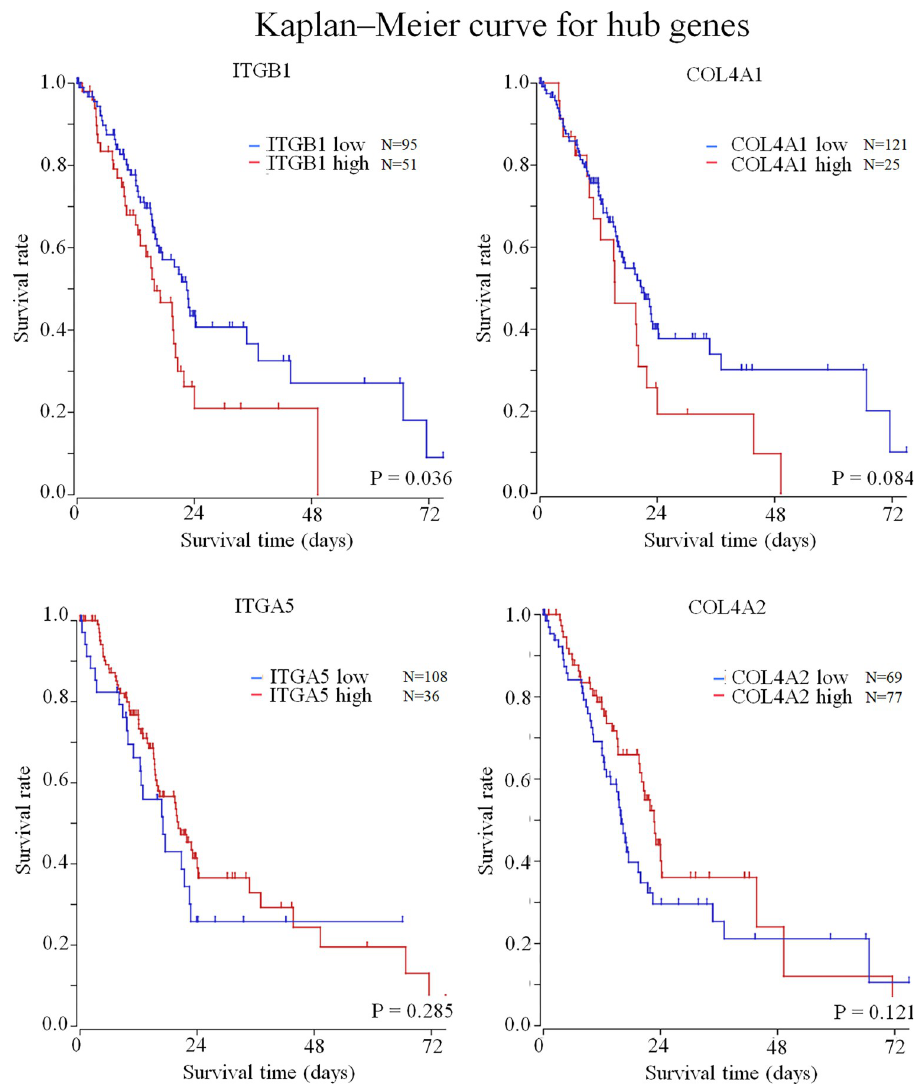
Fig 2. Kaplan–Meier curve for pre-validation of the hub genes by the R2 platform. The four hub genes detected by protein-protein interaction analysis were pre-verified for prognosis using the R2 platform, an open-source external databank. Prognostic analysis with the R2 platform using TCGA showed ITGB1 to be significantly involved in the deterioration of prognosis (p = 0.036). The expression of COL4A1 , COL4A2 , and ITGA5 was not significantly correlated with poor prognosis (p = 0.084, 0.121.